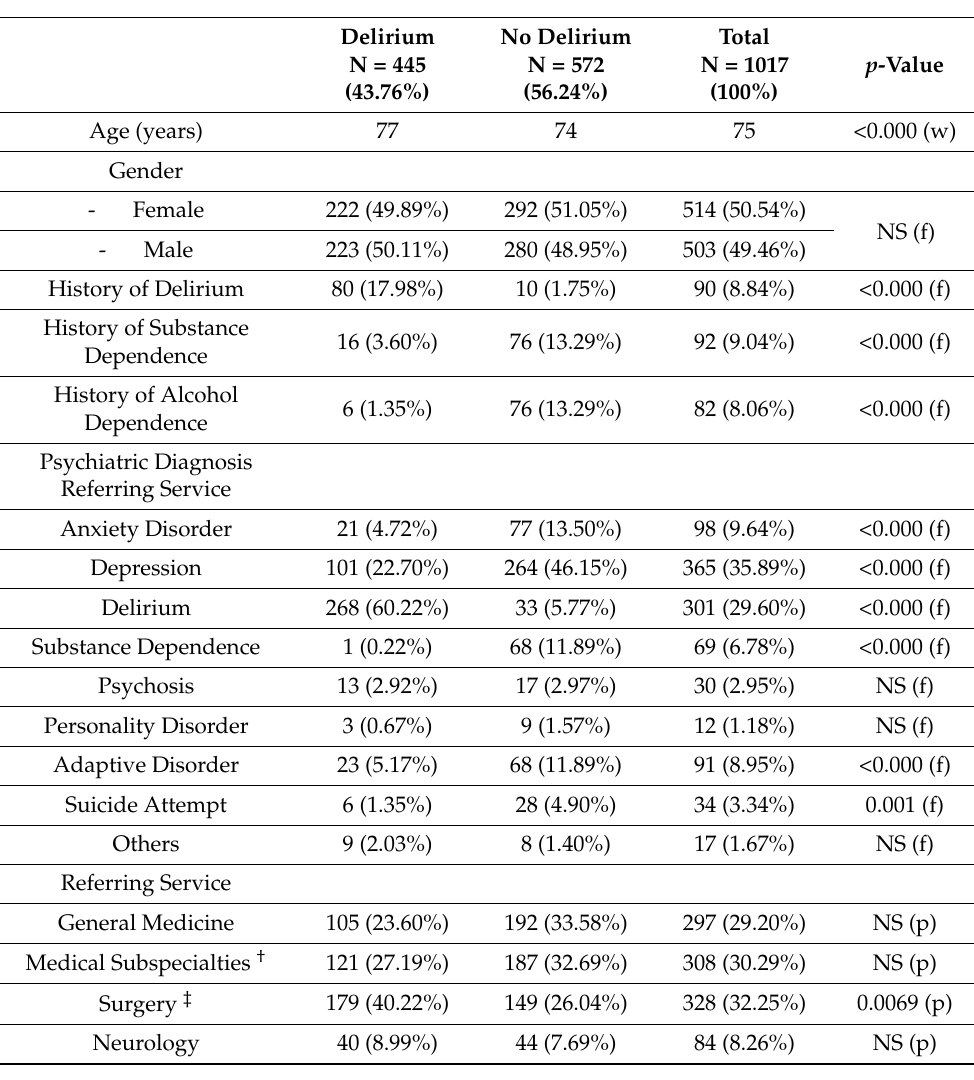
Table 1. Sociodemographic and clinical features of delirium group compared with the others psychi- atric